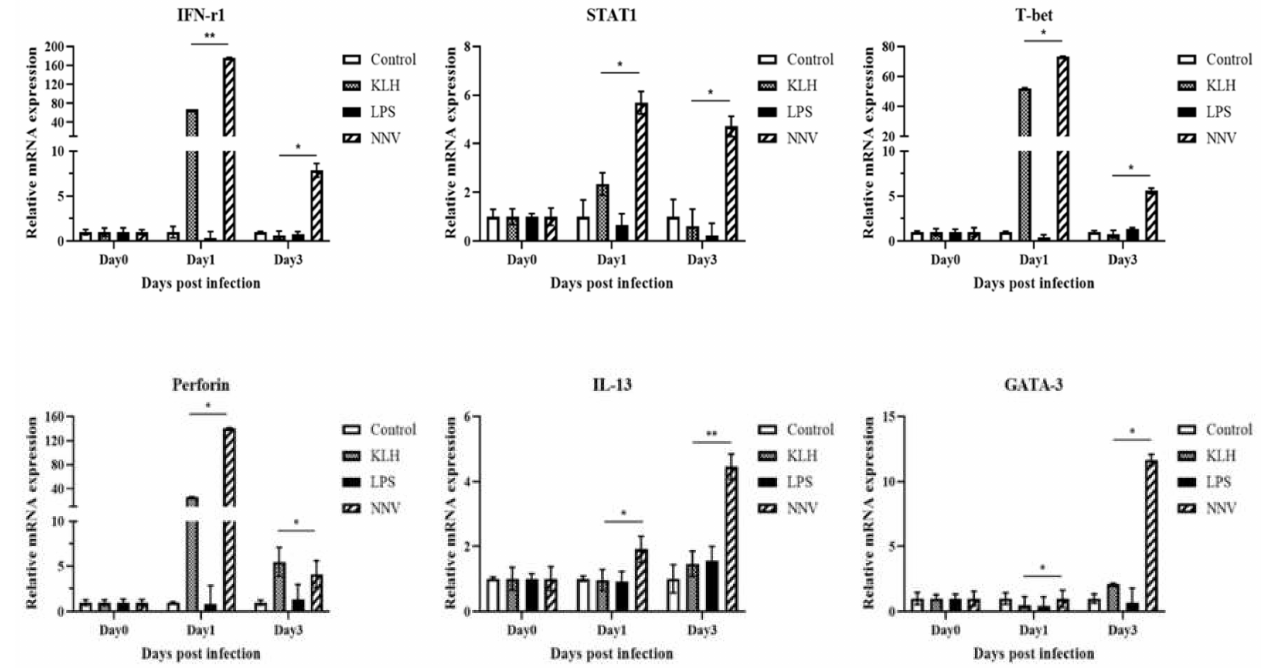
Figure 11. Gene expression analysis of transcription factors and cytokines after stimulation with NNV, KLH and LPS by qPCR. The mRNA level of each gene was normalized to that of β -actin and the error bars represent the standard deviation of results obtained from three fish. The asterisk indicates significant differences compared to the control (* p < 0.05, ** p < 0.01) based on ANOVA